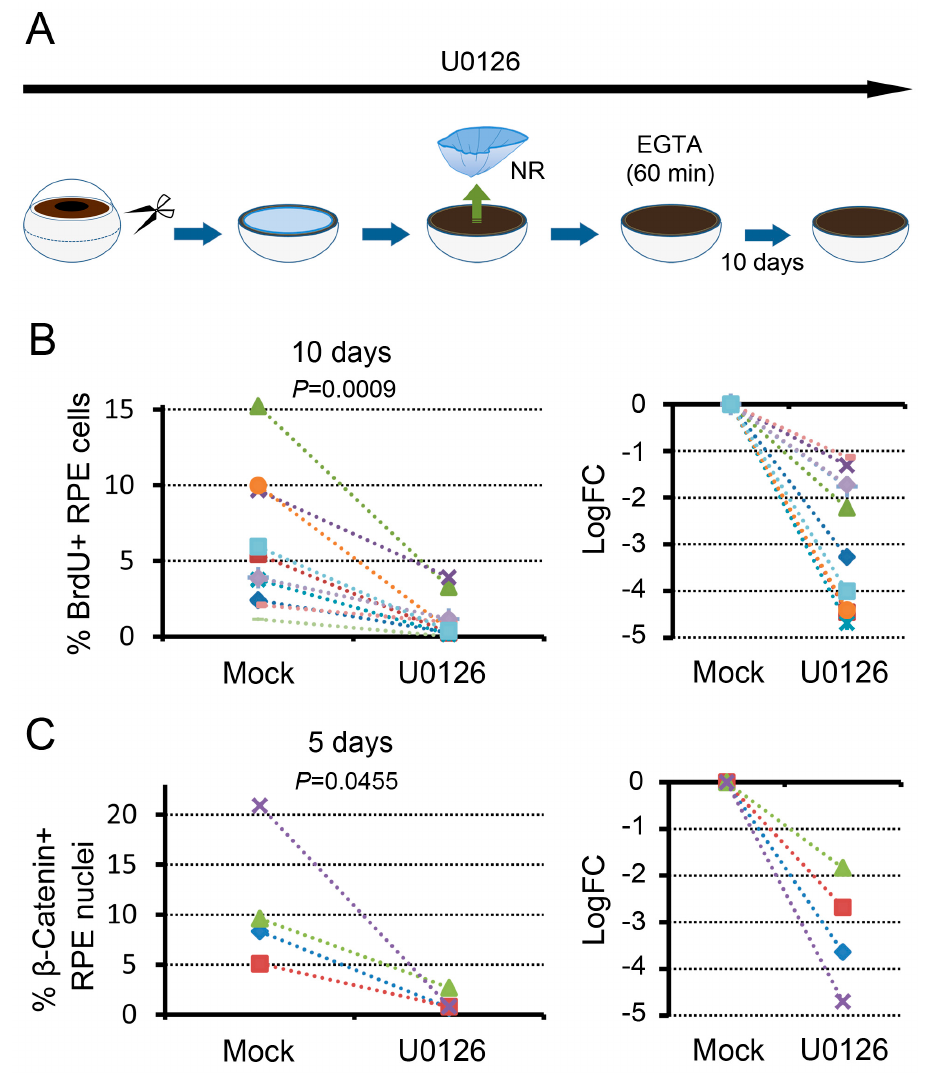
Figure 7. MEK-ERK signaling is a prerequisite for the promotion of cell cycle re-entry of RPE cells mediated by β -catenin signaling. ( A ) Schematic showing an experimental paradigm; ( B ) Effect of U0126 on cell cycle re-entry of RPE cells that was promoted by EGTA treatment (11 newts). The left hand graph shows the proportion of BrdU+ cells in the Center of the RPE on day 10, and the right hand graph shows the relative changes in the presence of U0126. The value was significantly lower (Sheffe’s pairwise comparison test following the Friedman test, P = 0.0009) in the presence of U0126; ( C ) Effect of U0126 on nuclear translocation of β -catenin in RPE cells that was promoted by EGTA treatment (4 newts). The left hand graph shows the proportion of β -catenin+ nuclei in the Center of the RPE on day 5, and the right hand graph shows the relative changes in the presence of U0126. The value decreased significantly (Sheffe’s pairwise comparison test following the Friedman test, P = 0.0455) in the presence of U0126.